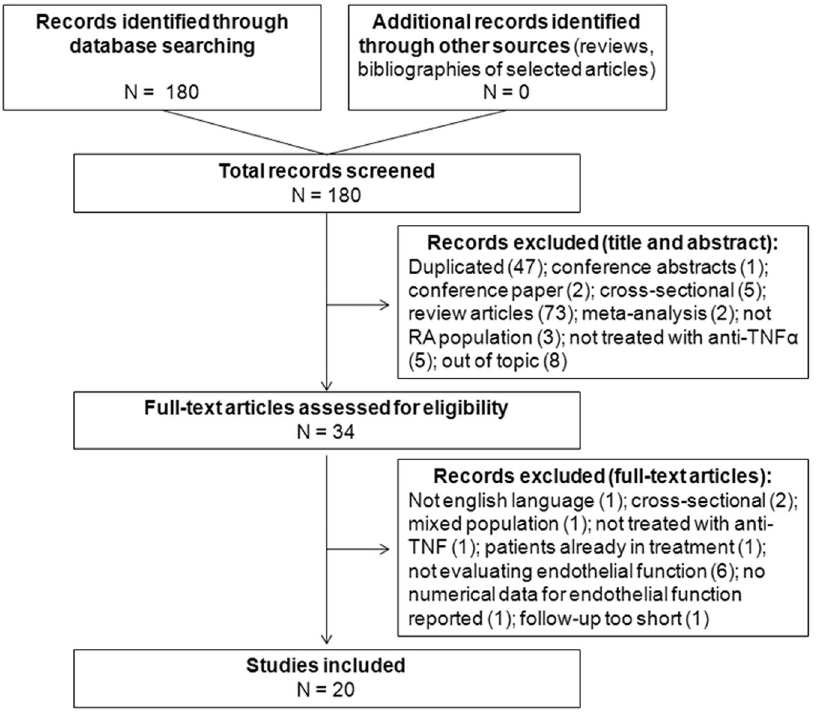
Figure 1. Study selection flow-chart. The process of search and selection of studies is disclosed. Causes of exclusion at each step are described and the number of studies excluded is reported in